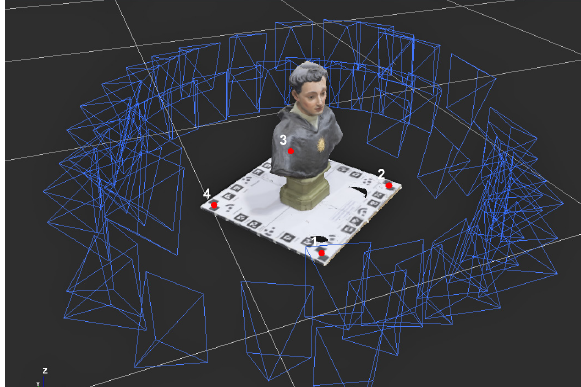
Figure 7. HDR photogrammetry model (Canon EOS5 Mark II with 24 mm / f 1.4 and processing with 3DFlow Zephyr)